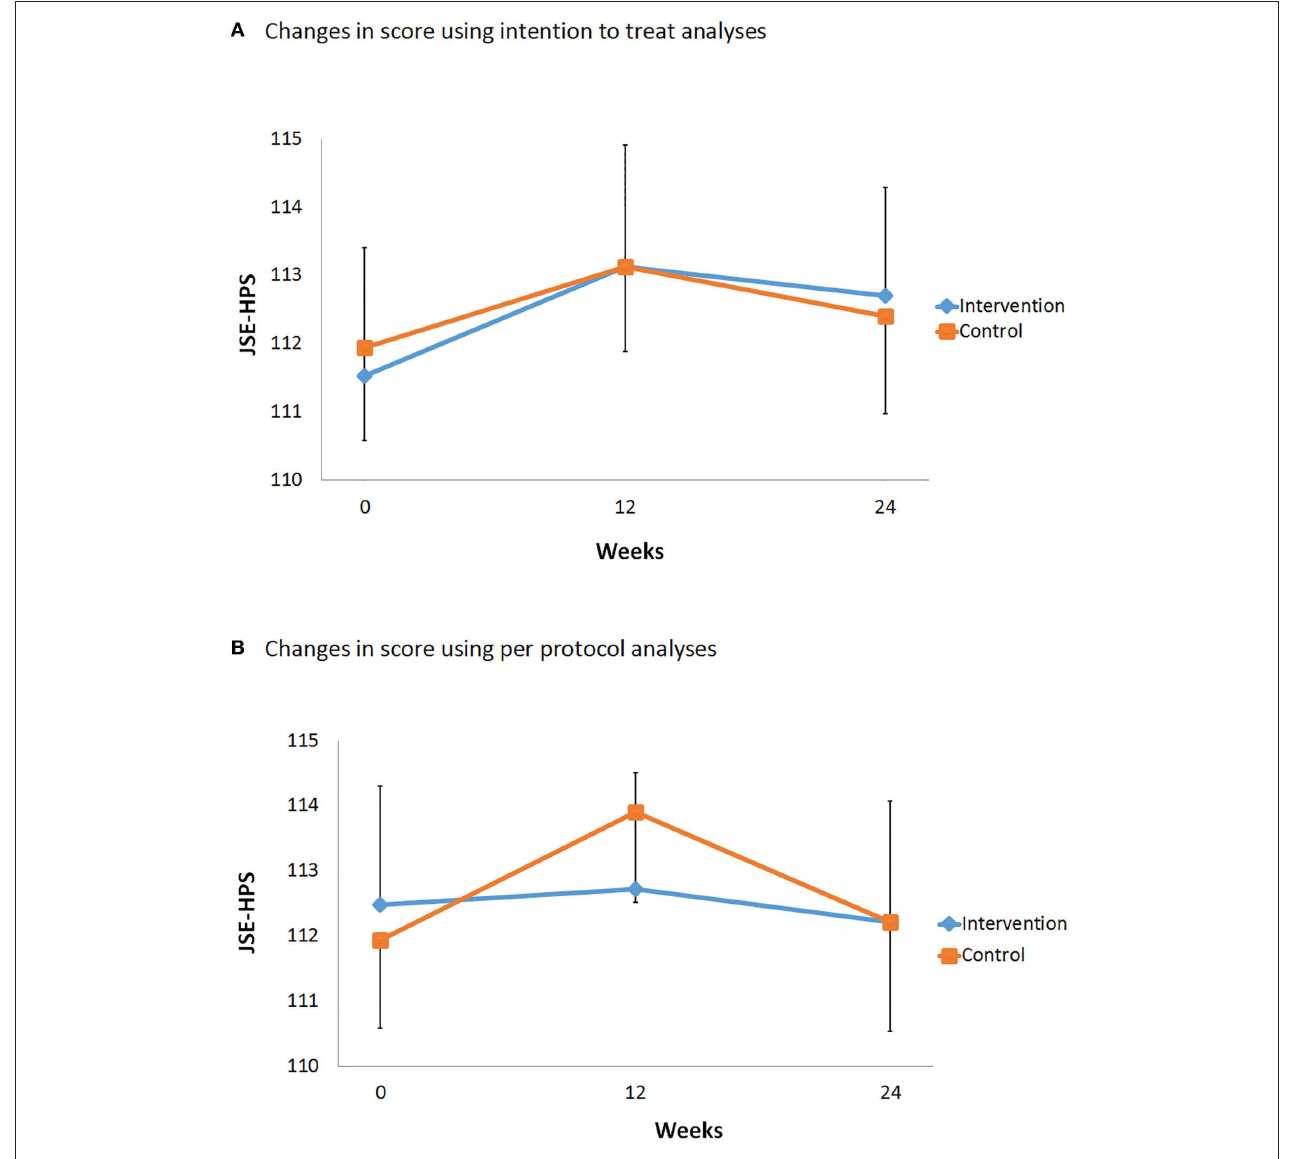
FIGURE 4 | Comparison of Jefferson Scale of Empathy–Health Profession Student score over time. The intervals represent standard error for each group. (A) Intention-to-treat analysis. (B) Per-protocol